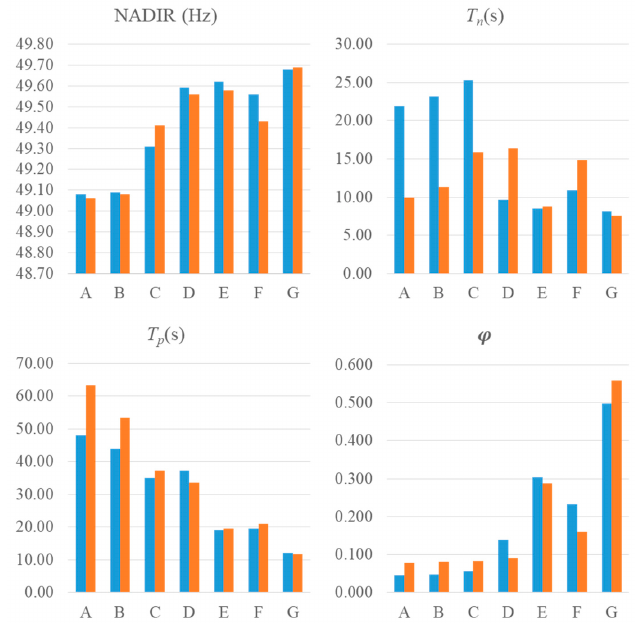
Figure 7. Evolution of response indicators for different cases. Blue bars represent simulations assuming constant wind speed of 10 m/s while orange bars represent simulations assuming constant wind speed of 20 m/s.